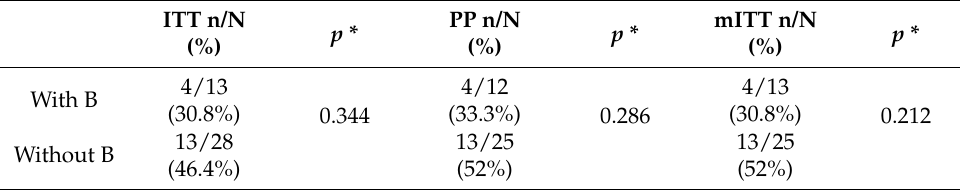
Table 4. Effectiveness of HDDT rescue treatment with and without